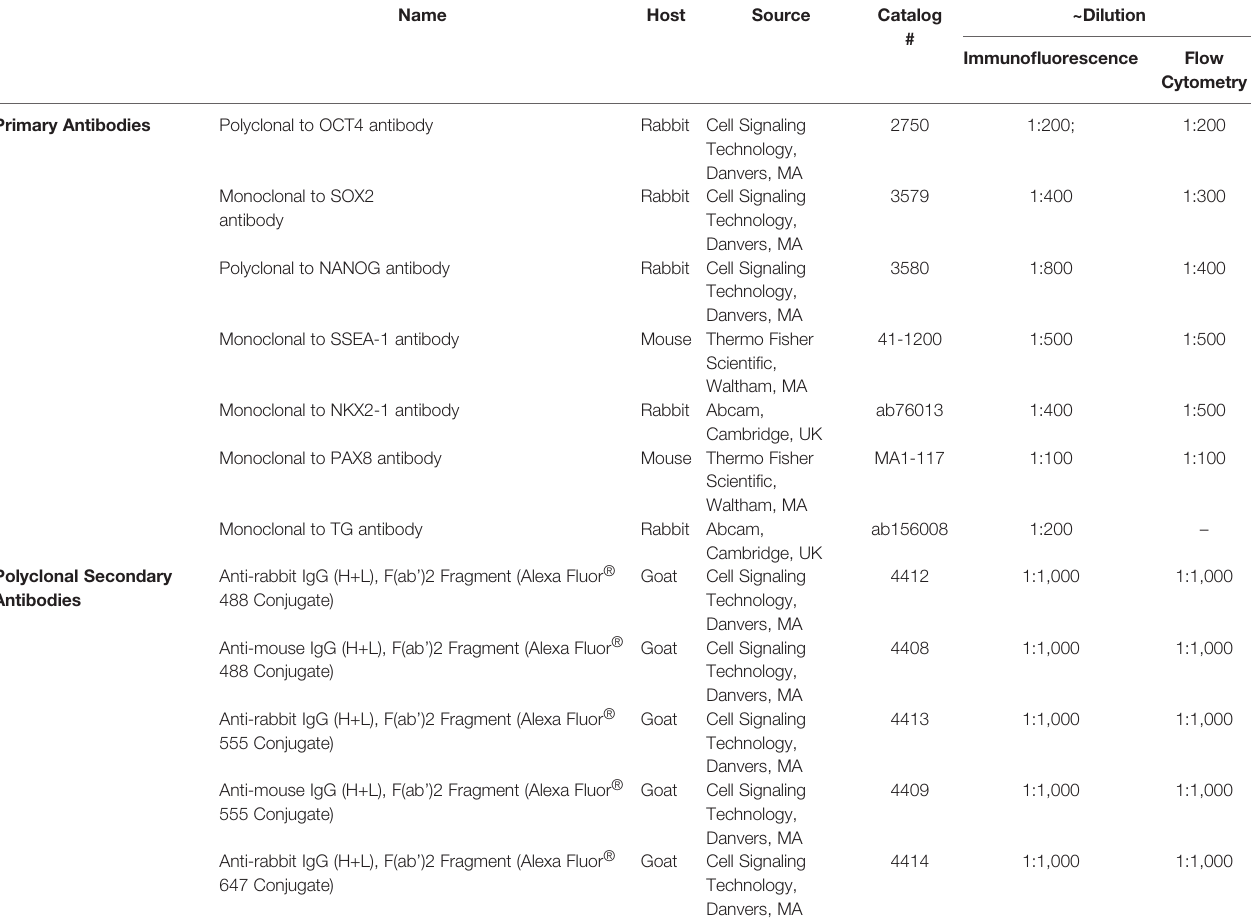
TABLE 1 | Antibodies used in the described